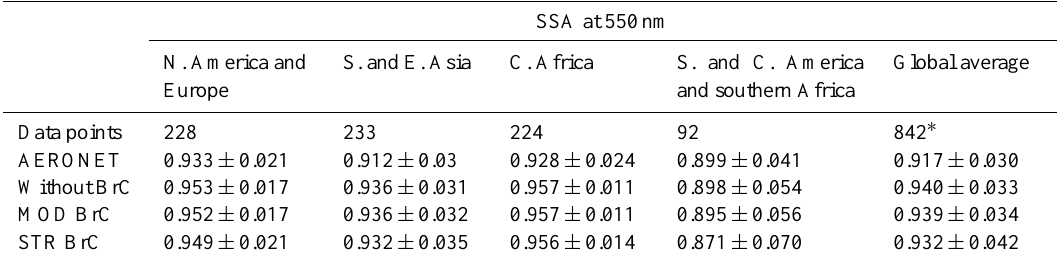
Table 3. The calculated global and regional average single-scattering albedo (SSA) values at 550nm from different model simulations, compared with AERONET data.